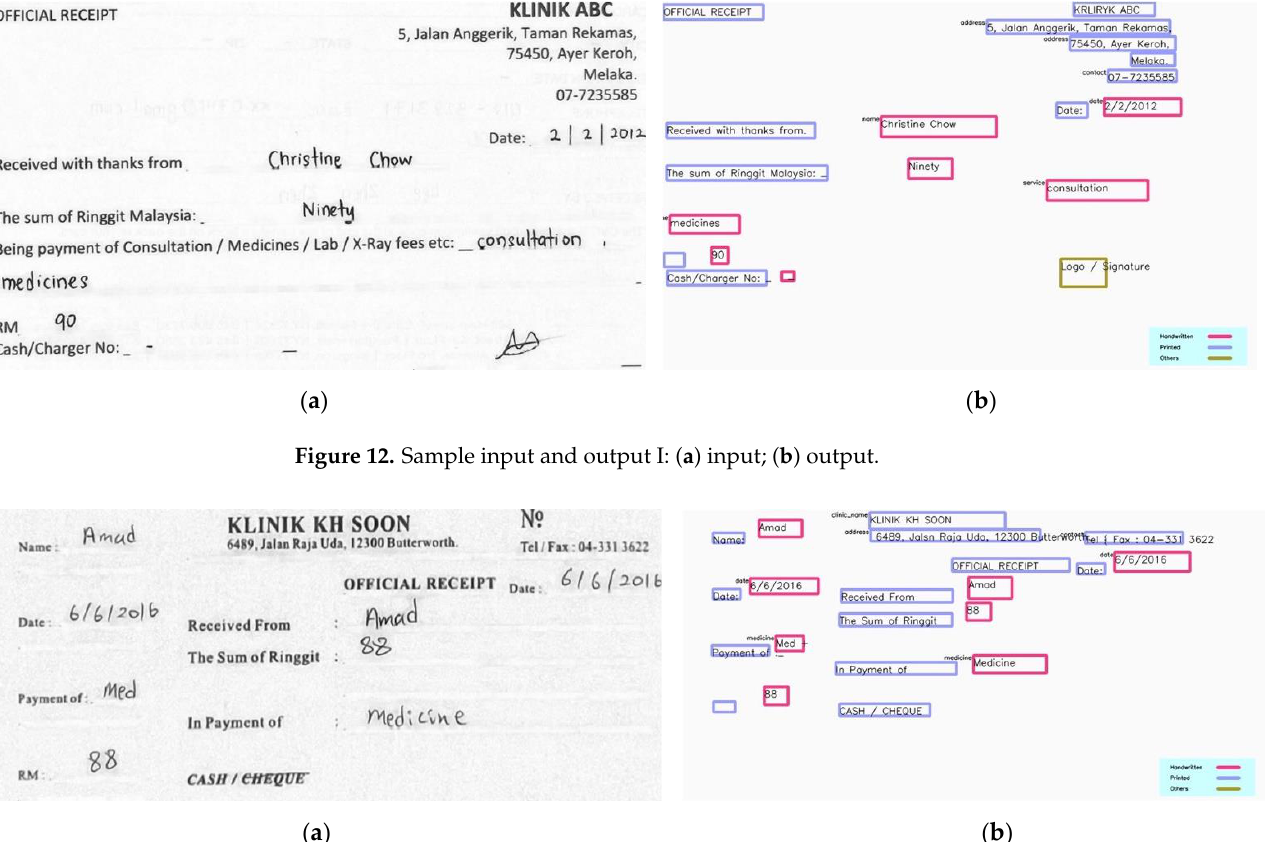
( c ) Figure 11. Experimental results of the ResNet-101T: ( a ) training and validation loss of the Trans- former model; ( b ) training and validation loss of the LSTM model; ( c ) training and validation loss of ViT. 4.6. Demonstration This section demonstrates some of the sample input and output of the proposed method. Figures 12 and 13 show the transcription results of the proposed HTR pipeline for different receipt templates. The printed text region is highlighted in blue, while the